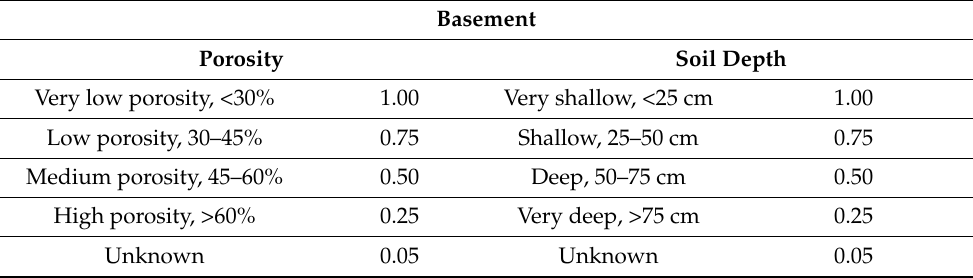
Table 4. Geological–hydrological category “Basement” and corresponding subcategories with proba- bility values.